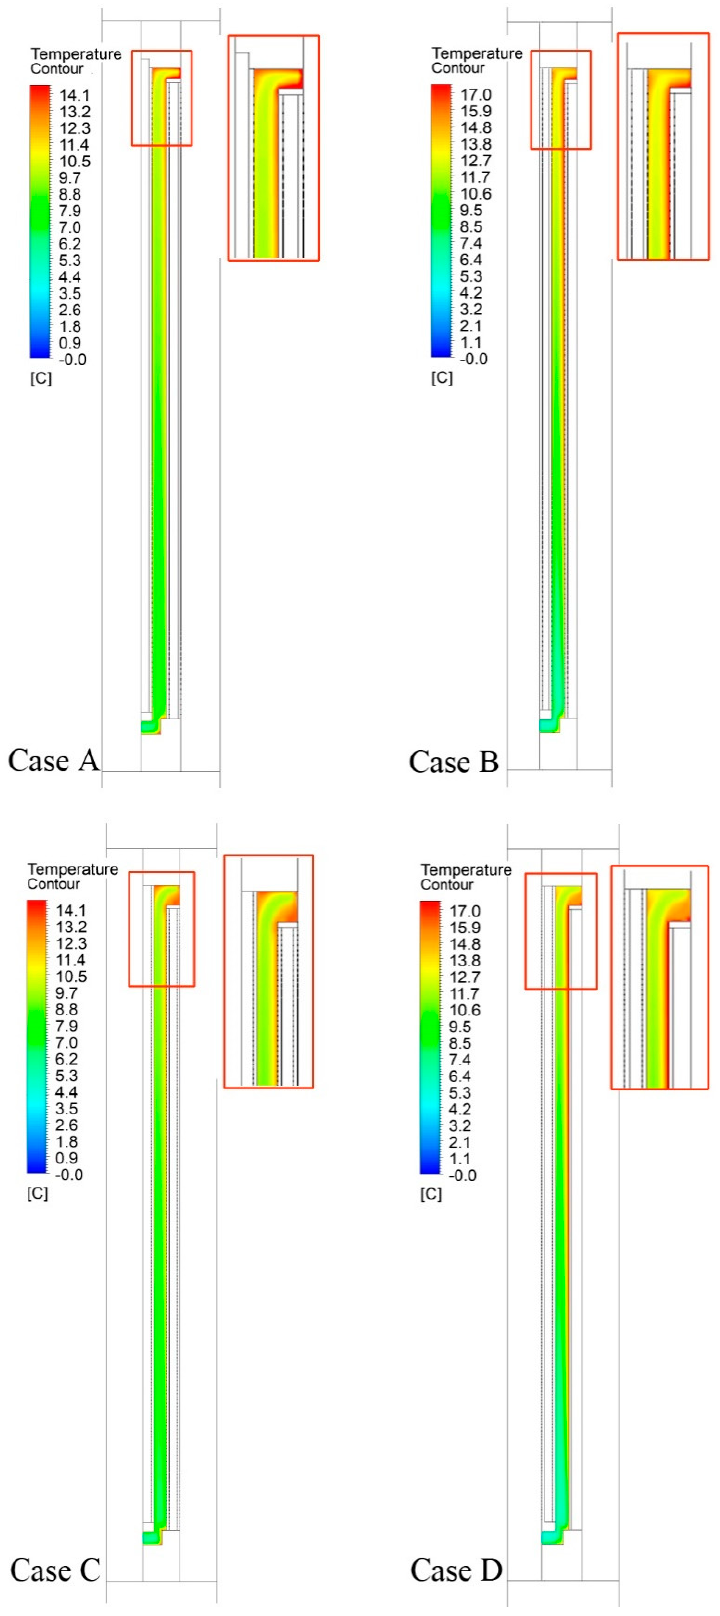
Figure 10. Temperature distribution within the cavity for the different cases.